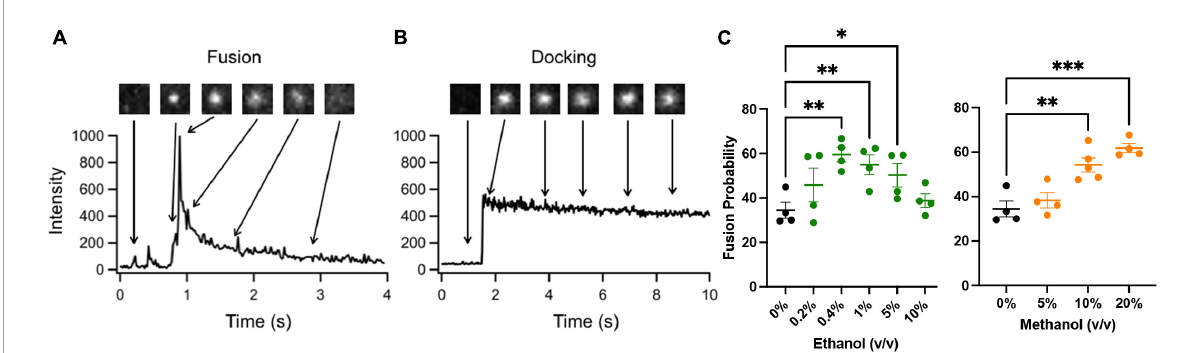
FIGURE2 SNARE-driven fusion assay quantifies fusion probability in the presence of alcohol. (A,B) the top boxes are fluorescence images of a single vesicle at the corresponding time in the line graph. The line graph represents the peak fluorescence intensity originating from the vesicle site. (A) Shows a single docking and fusion event as a large spike in fluorescence intensity with subsequent rapid decay as the labeled lipids diffuse away. (B) Shows a docking event as a sudden jump in fluorescence intensity with no subsequent decay indicating that fusion did not occur. (C) Fusion probabilities determined in the presence of buffer with different concentrations of ethanol (green) or methanol (orange) compared to controls (black). Notice that 0.4% v/v (68 mM) ethanol significantly increases fusion probability, while 0.2% (34 mM) shows an intermediate fusion probability but is not significantly different from control. Methanol does not show an increase in fusion probability until 10%. Fusion probability is expressed as % of docking events that undergo fusion, (i.e., successful fusion/total docking events). Error bars are 95% confidence intervals, ∗ , ∗∗ , and ∗∗∗ indicates p ≤ 0.05, p ≤ 0.01, and p ≤ 0.001 respectively compared to controls (one-way ANOVA, n ≥